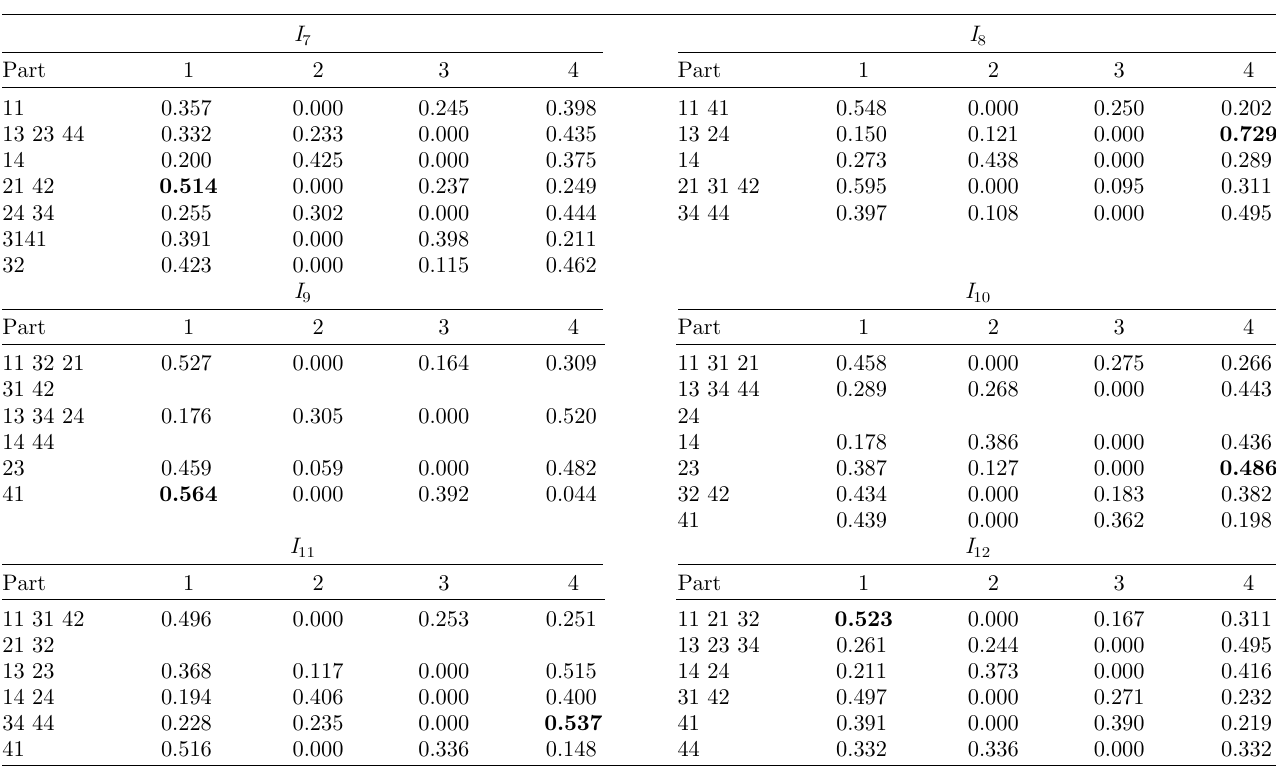
Table 7. PMM for the irregular clusters I i , i = 7, ... , 12 see equation (4) and Remark 1. In bold type the highest probability for the cluster.